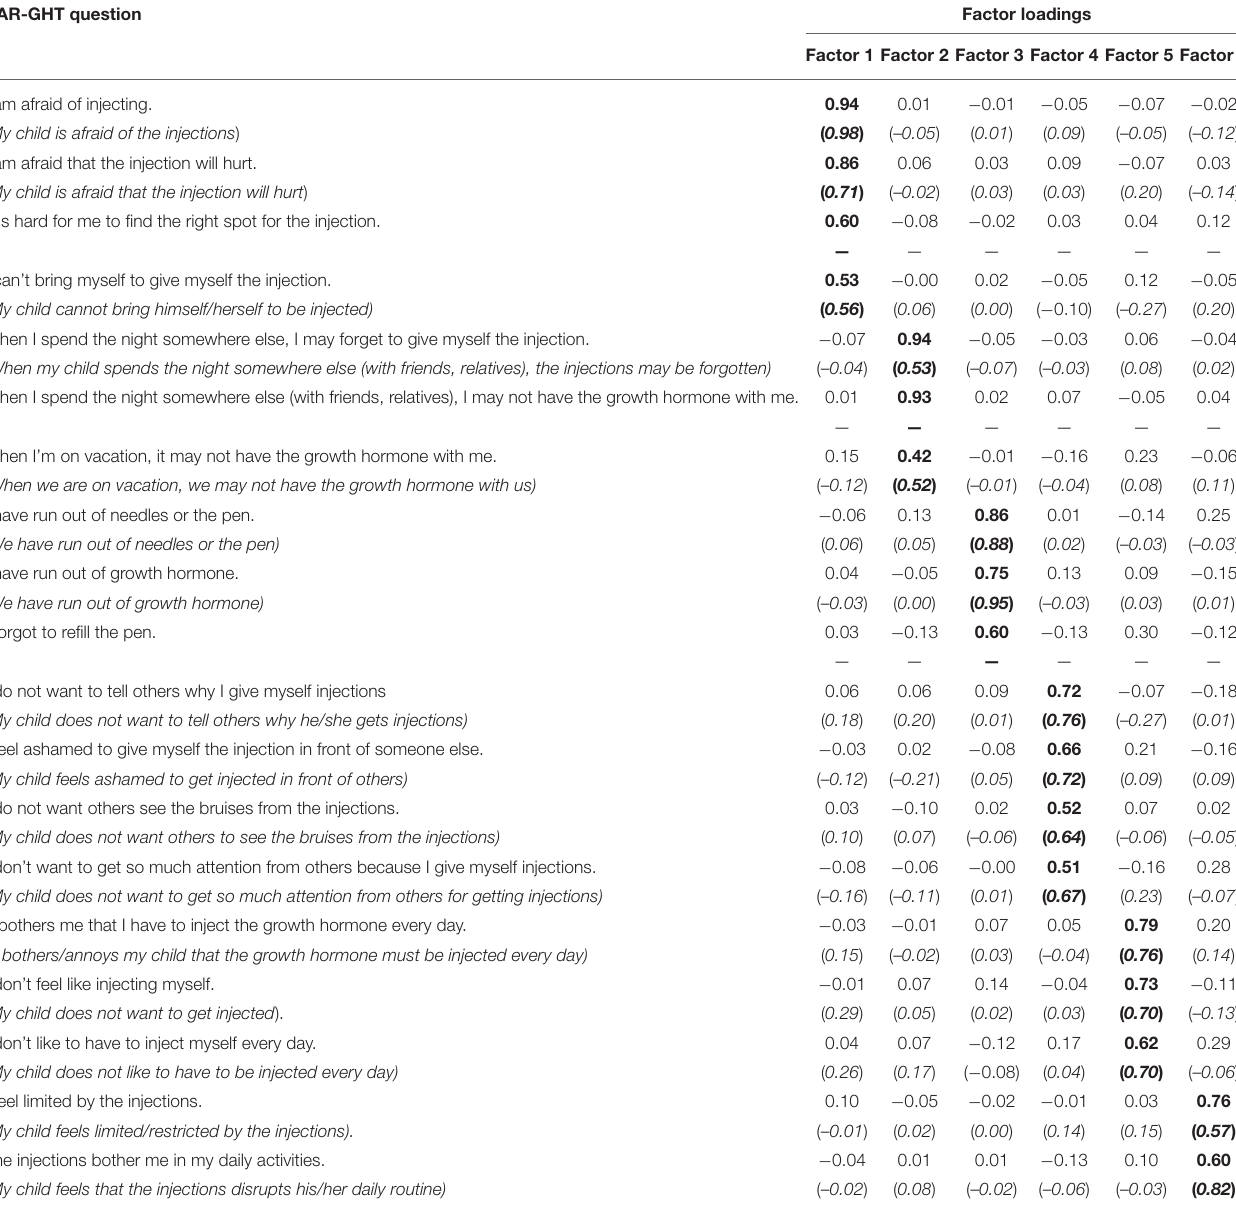
TABLE 3 | Exploratory factor analysis of BAR-GHT baseline items in the child/adolescent sample and parent samples. BAR-GHT